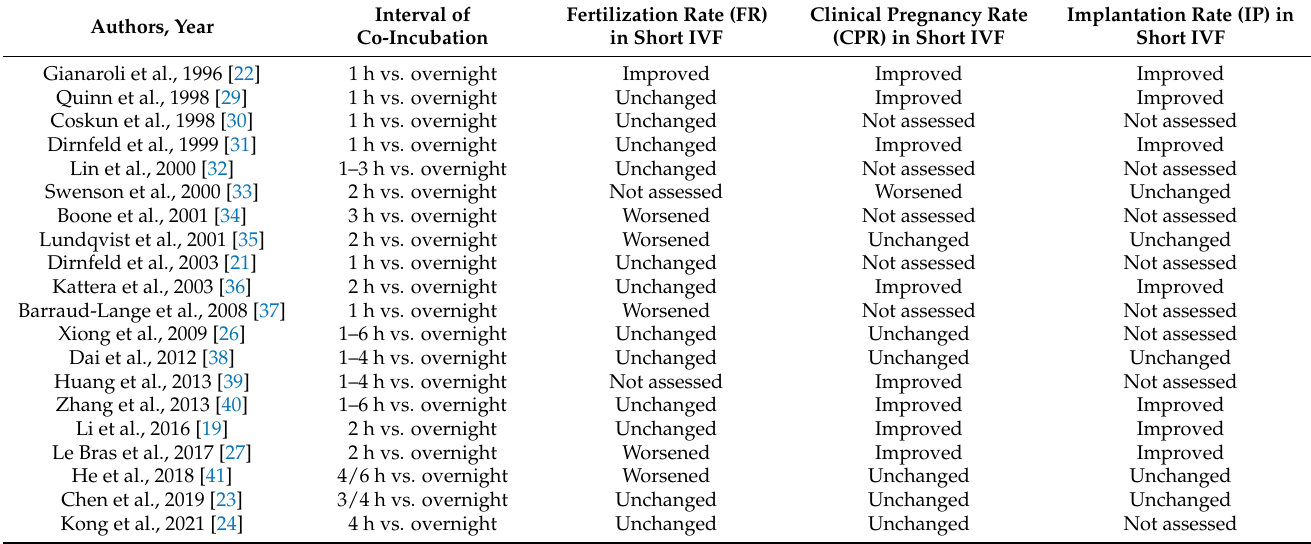
Table 1. Results deriving from the comparison between different incubation intervals of spermatozoa and oocytes in in vitro fertilization